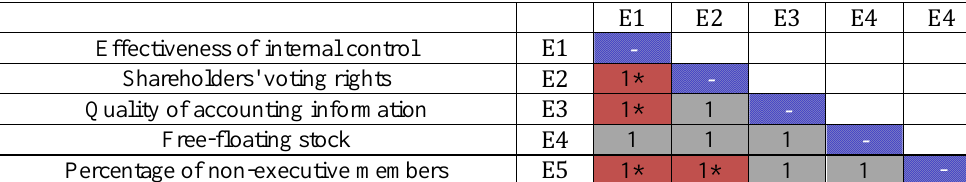
Table 14.examines the interpretive Effect of the level of Investor Protection based on sociocracy Effectiveness of internal control - Shareholders' voting rights - Quality of accounting information